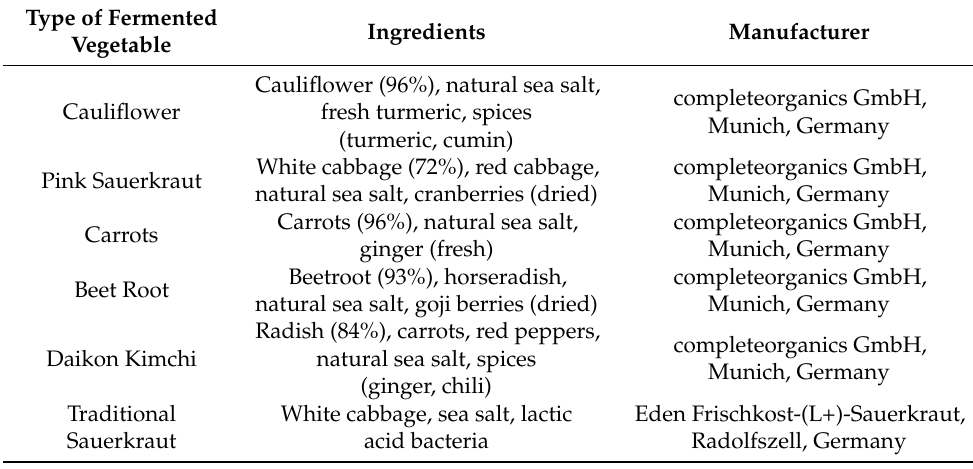
Table A1. Compositional details of the fermented vegetables used in this